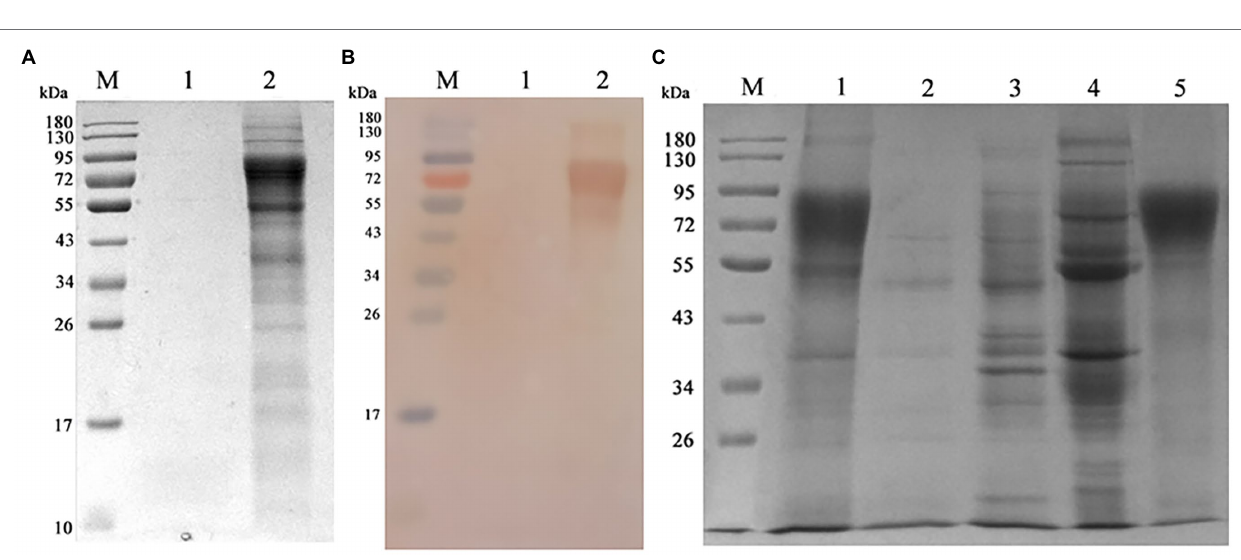
FIGURE 4 | Expressing and purification of gE protein. (A) The CHO and CHO-gE supernatant were collected and analyzed by SDS-PAGE, separately. M: marker; 1: CHO supernatant; 2: CHO-gE supernatant. (B) The CHO and CHO-gE supernatant were collected and identified by Western blotting, separately. M: marker; 1: